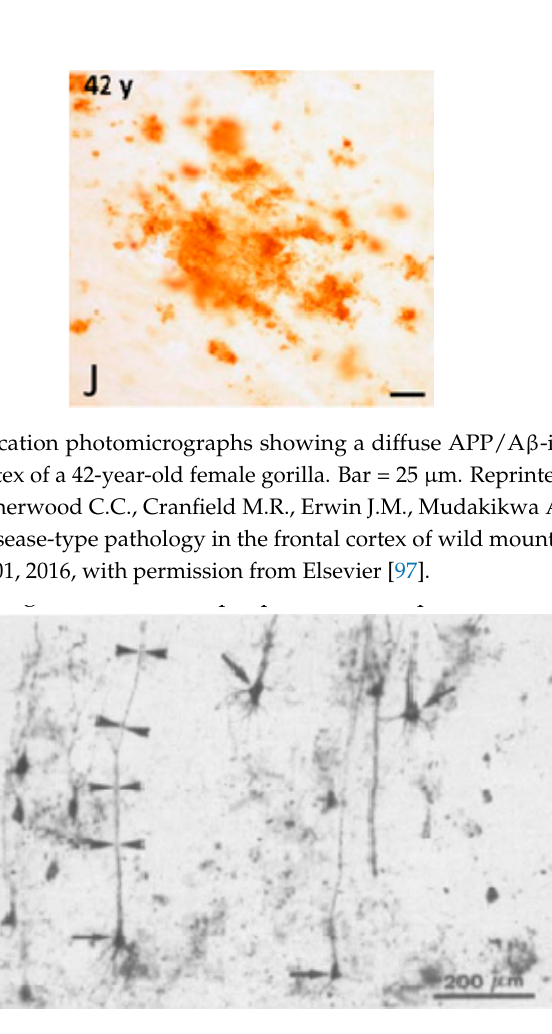
Figure 11. Cytoskeletal pathology in neurons of the baboon labeled by AT8-immunostaining. Deposition of abnormal tau in pyramidal neurons of the first Ammon’s hom sector (CA1). Abnormal tau is deposited in cell bodies (arrows) and apical dendrites (arrowheads) of CA1 pyramidal neurons (Bar = 200 µ m; 30-year-old baboon). Reprinted by permission from Springer Nature, Advances in